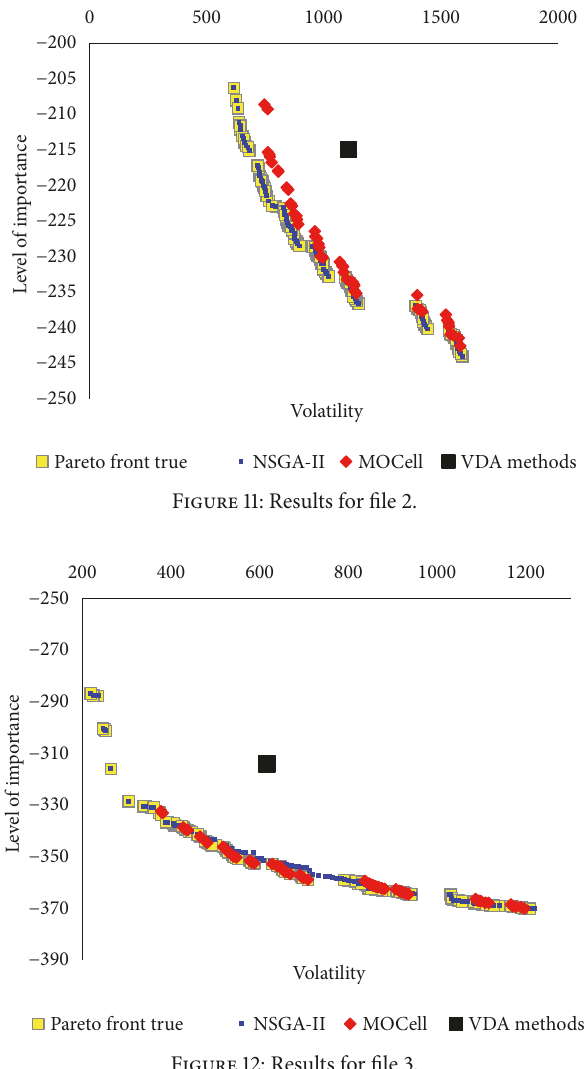
Figure 13: Results for file